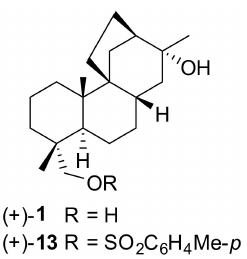
Figure 1. ( + )-stemarin ( 1 ) and corresponding C(18) tosylate ( 13 ).